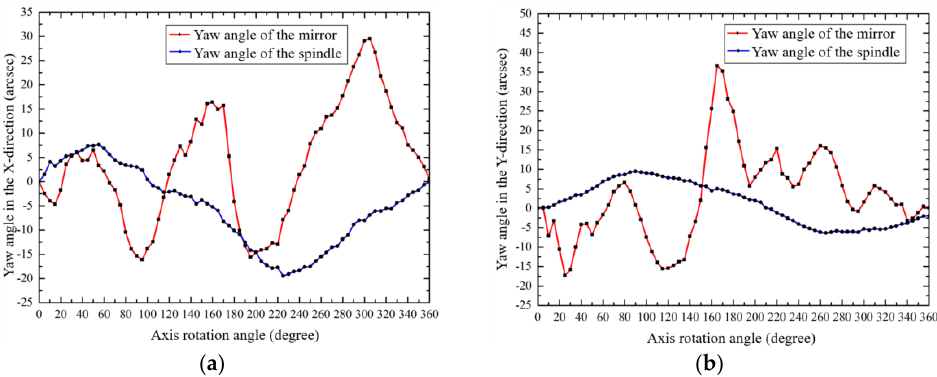
Figure 11. The motion tilt error of the mirror and the shaft: ( a ) X-direction; ( b ) Y-direction.